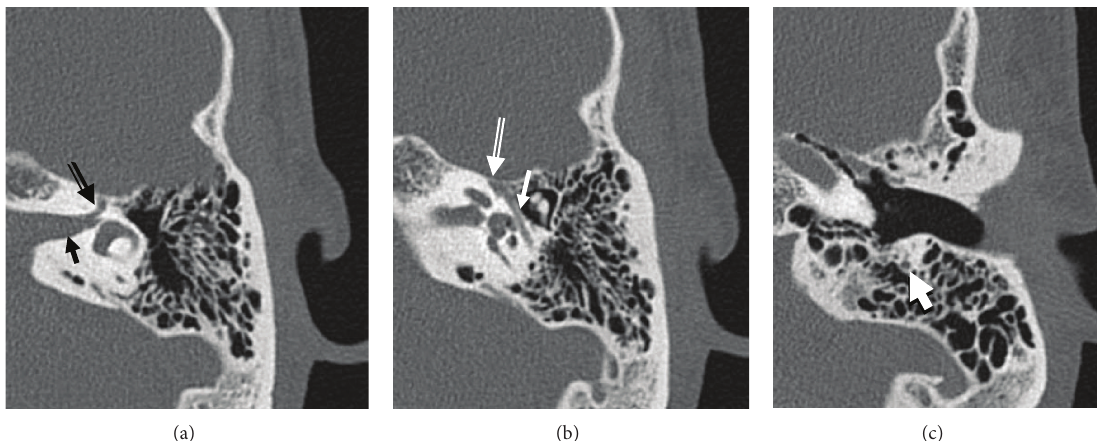
Figure 2: Normal facial nerve canal on CT. Axial temporal bone CT images demonstrate the intracanalicular (solid arrow in (a)), labyrinthine (doublelinedarrowin(a)),geniculateganglion(doublelinedarrowin(b)),tympanic(solidarrowin(b)),andmastoid(arrowin(c))segments of the facial nerve.